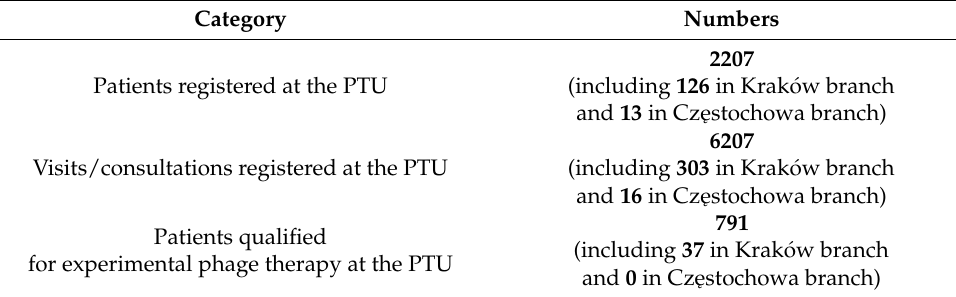
Table 1. The PTU’s activity in the years 2005–2021 (source: internal